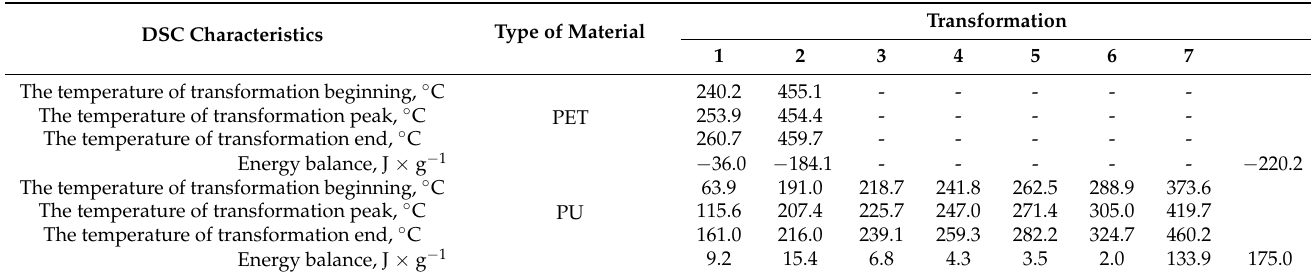
Table 6. Normalized transformation energy for successive transformations of tested plastic waste and energy balance of the process. DSC